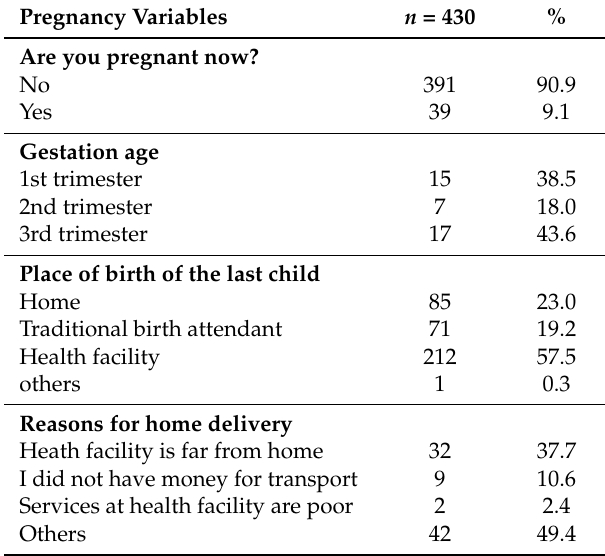
Table 2. Pregnancy status and place of delivery among women in Simiyu region, Tanzania in 2013.